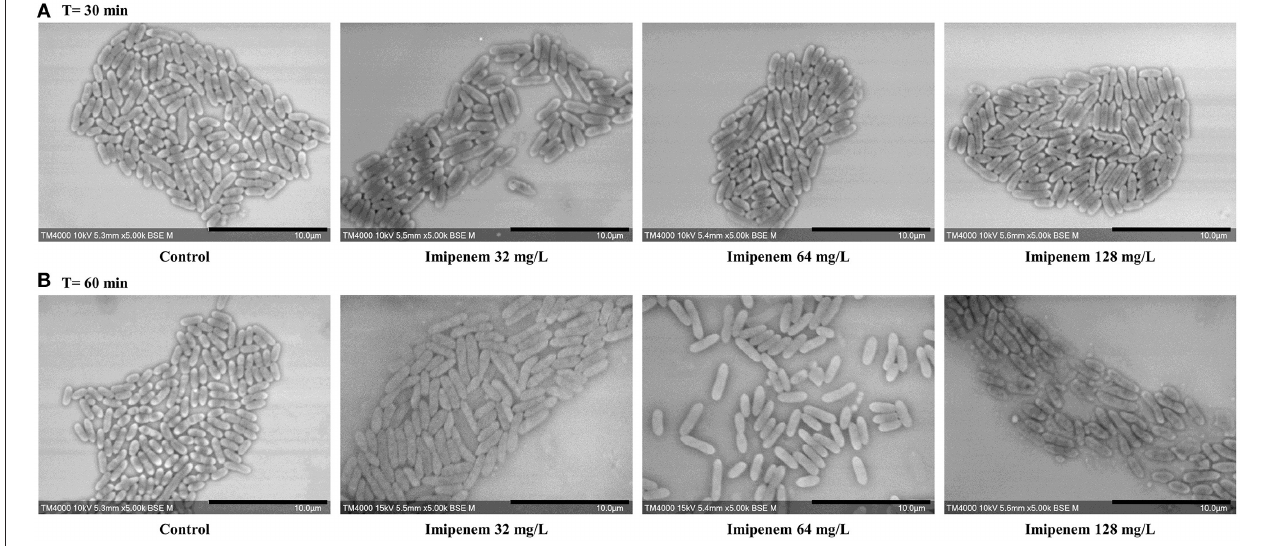
FIGURE 5 | Modifications observed on S. maltophilia incubated without IPM and with IPM. (A) After 30min. (B) After 60min. No significant morphological modifications were observed after incubation with increasing IPM concentrations for up to 60min. Micrographs recorded on TM4000 Plus. Scale bars: 10 µ m.